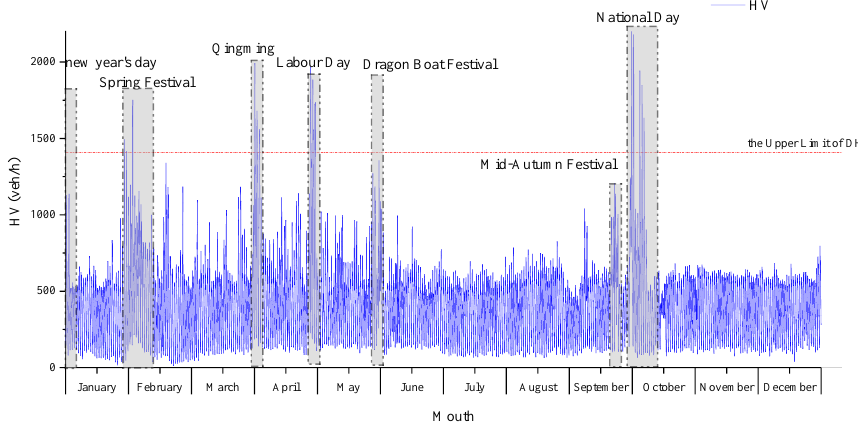
Figure 3. Time series of the hourly traffic volume distribution.